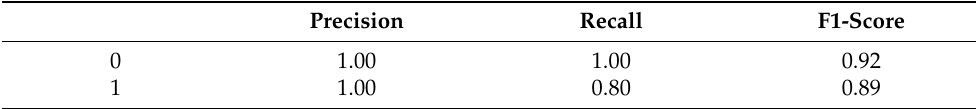
Table 2. Performance Metrics for Training Data.